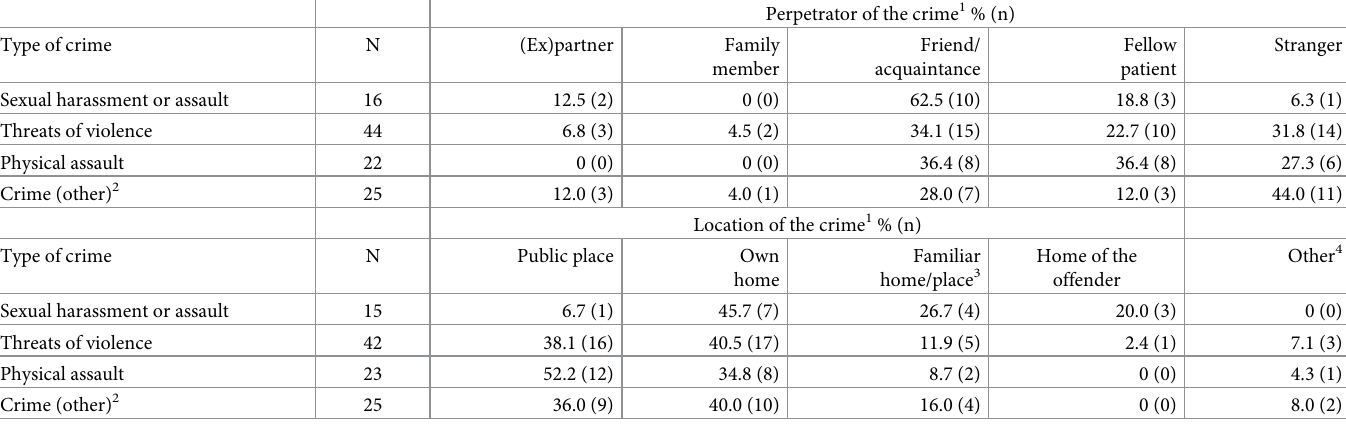
Table 2. Perpetrators and locations of the crime based on the